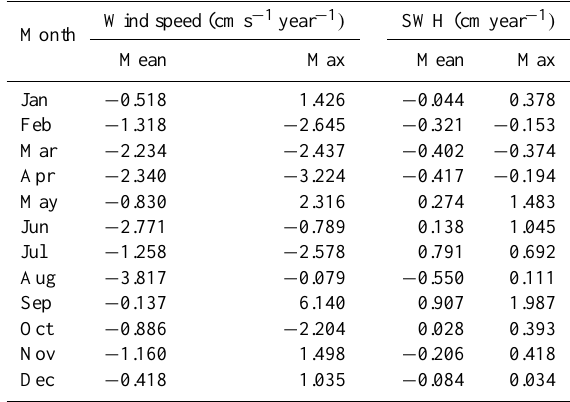
Table 1. Trend in wind speed and significant wave height (SWH) from 1979 to 2012 in different